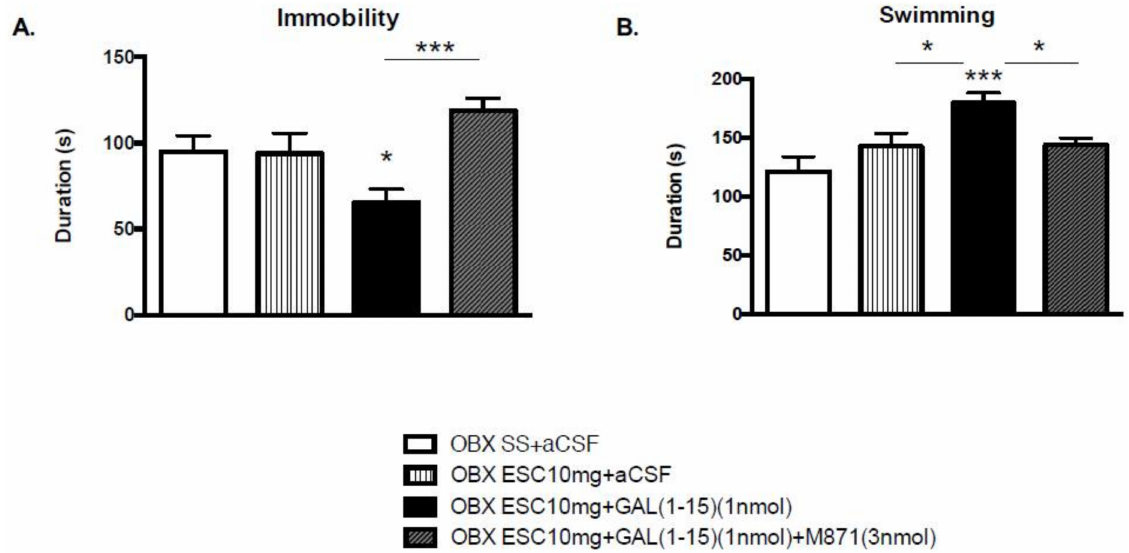
Figure 1. Behavioural effects of the coadministration of effective dose of ESC (10 mg/kg) and GAL(1-15) (1 nmol) in the forced swimming test (FST). Saline or ESC was administered intraperitoneal (ip) 23, 5, and 1 h before the test. aCSF, GAL(1-15) or M871 were injected intracerebroventricular (icv) 15 min before the test. Data represent mean ± SEM of immobility and swimming time in FST during the 5 min test period (n = 7–11 rats per group). In ( A ) * p < 0.05 versus OBX SS+aCSF and OBX ESC10mg+aCSF, in ( B ) *** p < 0.001 versus OBX SS+aCSF, according to one way ANOVA followed by Fisher multiple comparison